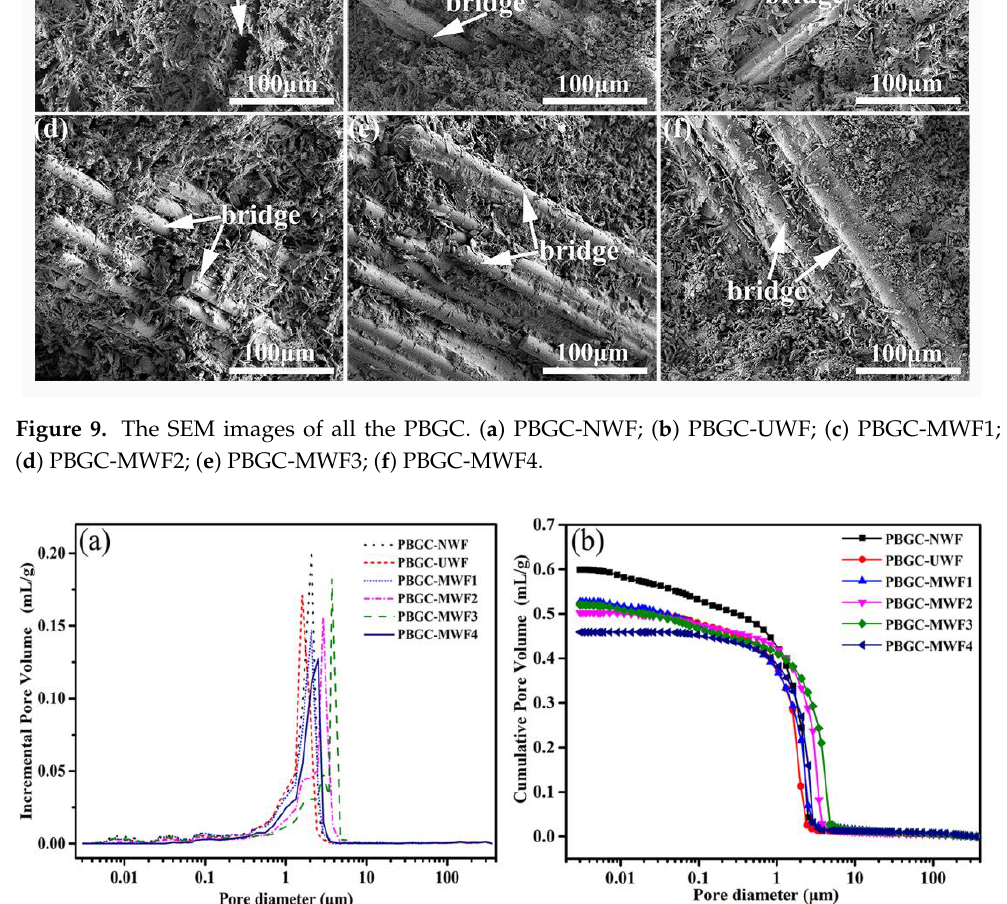
Figure 10. The pore size distribution and cumulative pore volume of all the PBGCs. ( a ) Pore size distribution; ( b ) cumulative pore volume. Table 3. Pore structure parameters of all the